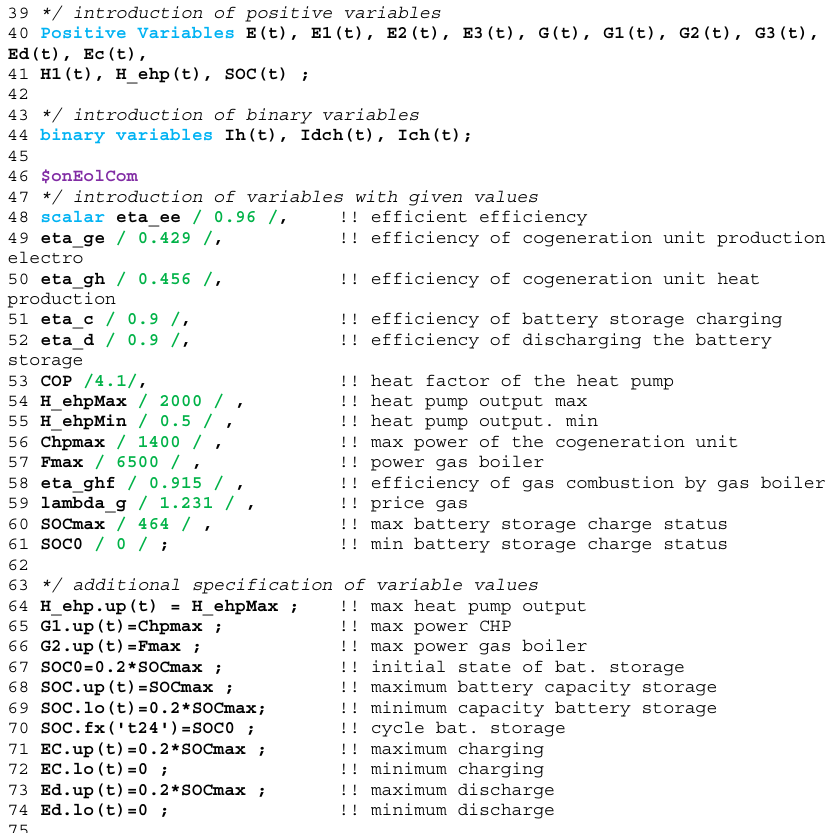
Figure 22. Input data code.